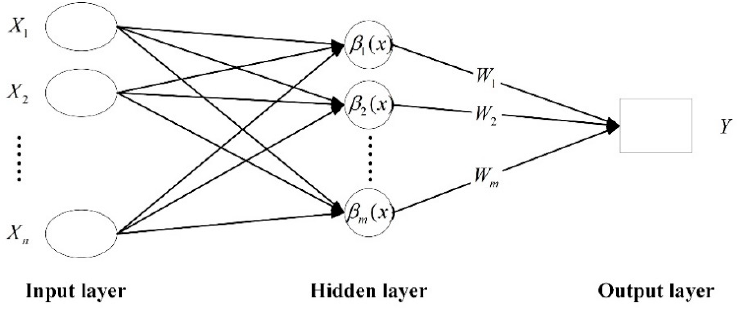
Figure 4. Neural network structure of radial basis function (RBF).